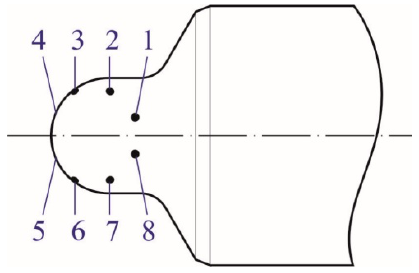
Figure 3. Numbering of orifices of the nozzles examined.